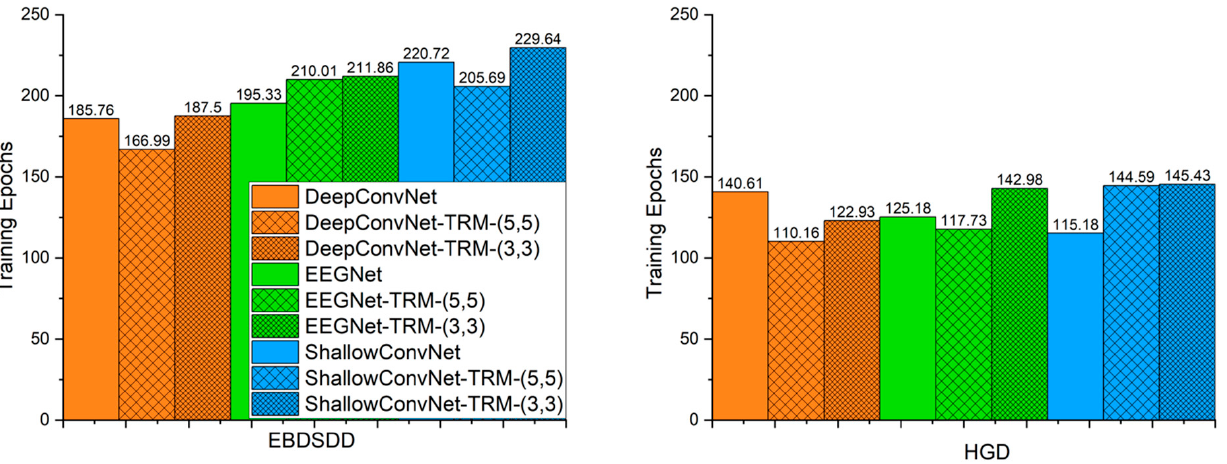
Figure 5. The average number of training epochs yielding the lowest validation loss for each algorithm. The left and right panels show the average numbers of training epochs yielding the lowest validation loss on the EBDSDD and HGD, respectively. Algorithms with “-TRM” use the TRM.